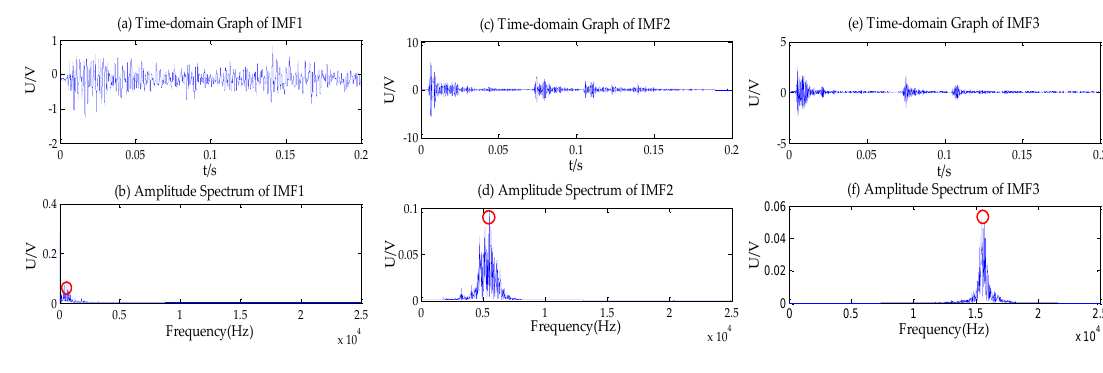
Figure 6. Time–frequency diagram of IMF1–IMF3.